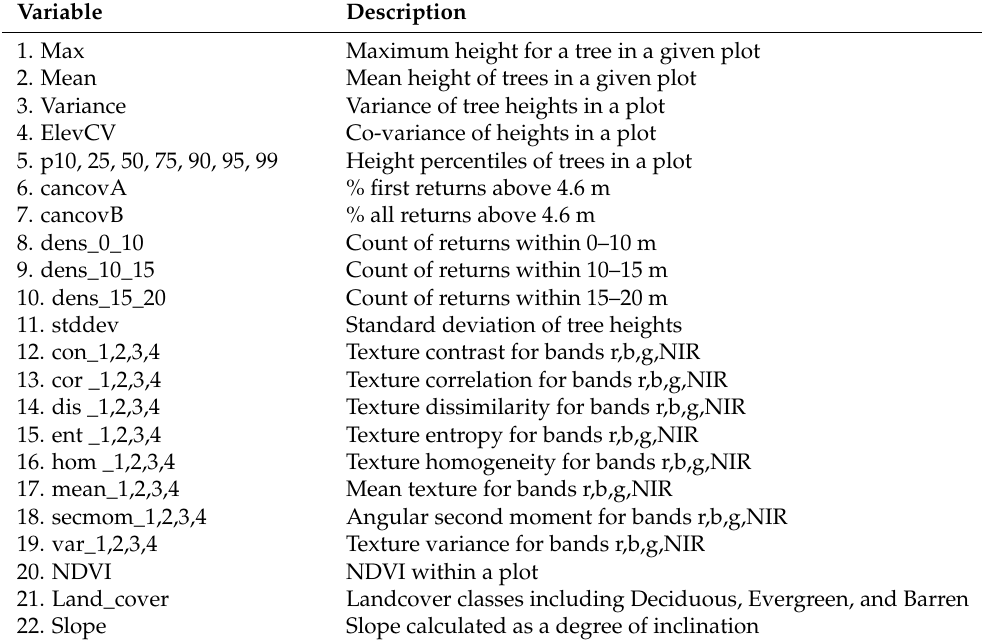
Table 4. Variables used in modeling. Note that repetitive variables such as height percentiles and texture metrics for each of 4 bands were grouped to reduce table